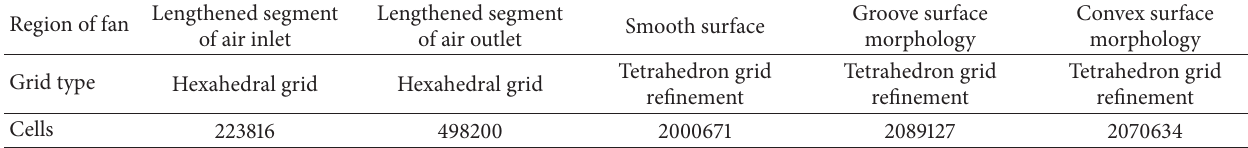
Table 1: Each computational grid information of centrifugal